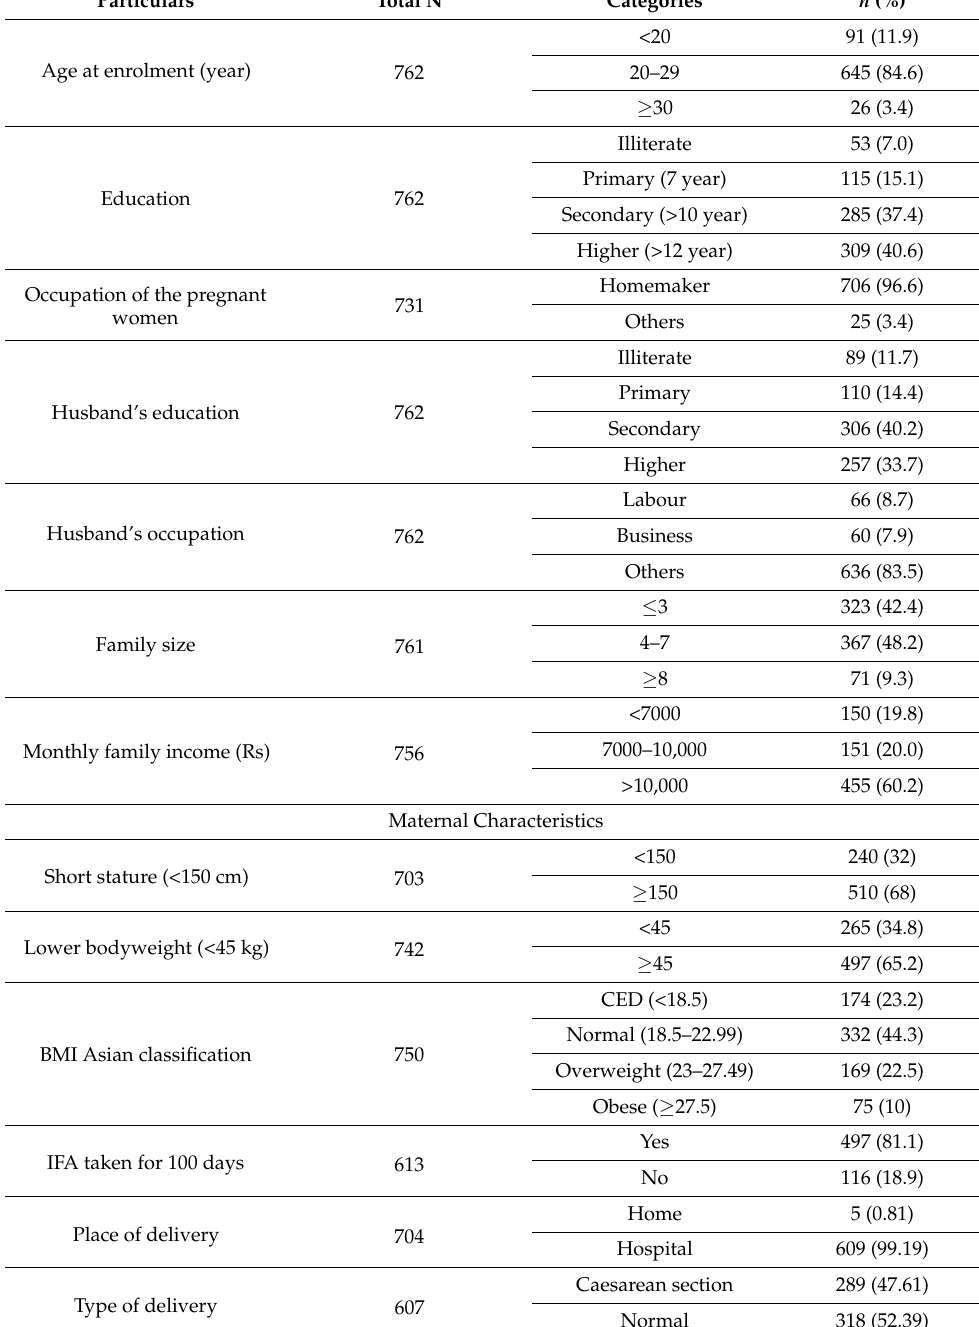
Table 1. Socio-demographic and maternal